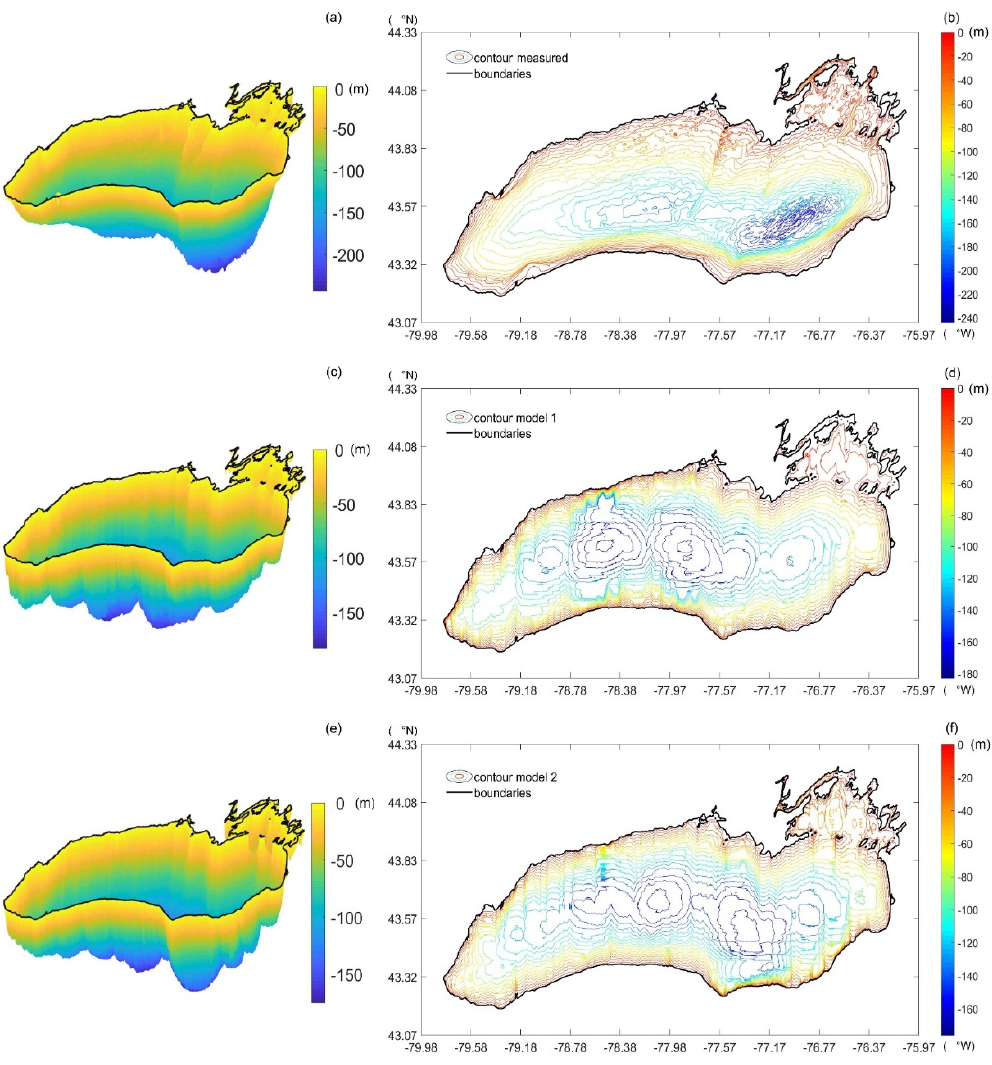
Figure 6. The modeling results of Lake Ontario. ( a ) 3D map of the measured bathymetric data; ( b ) contour map of the measured bathymetric data; ( c ) 3D map of the result using scaled model 1; ( d ) contour map of the result using scaled model 1; ( e ) 3D map of the result using scaled model 2; ( f ) contour map of the result using scaled model 2.